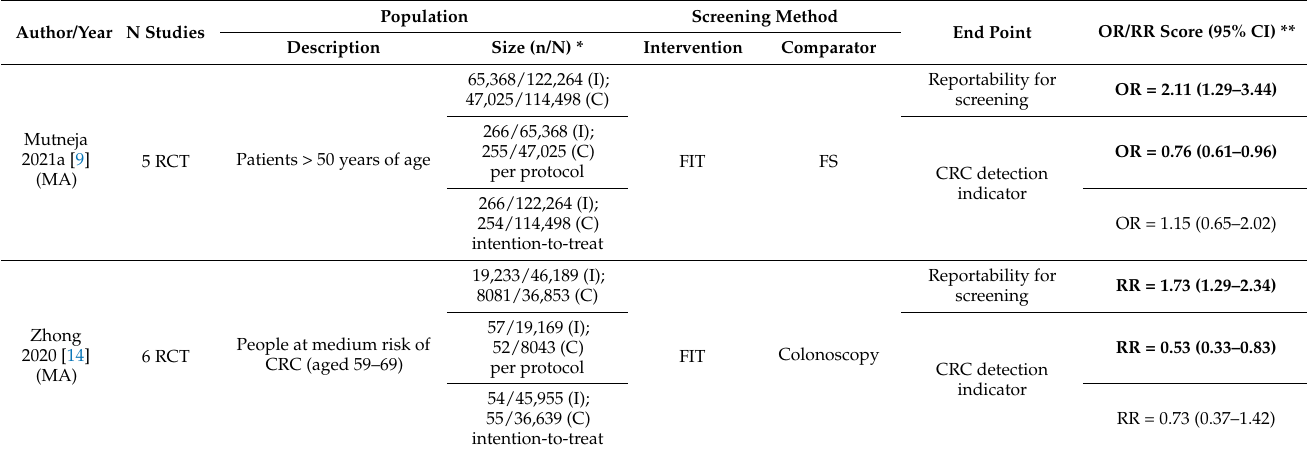
Table 2. Characteristics and results of studies on reporting for screening and detection of CRC.